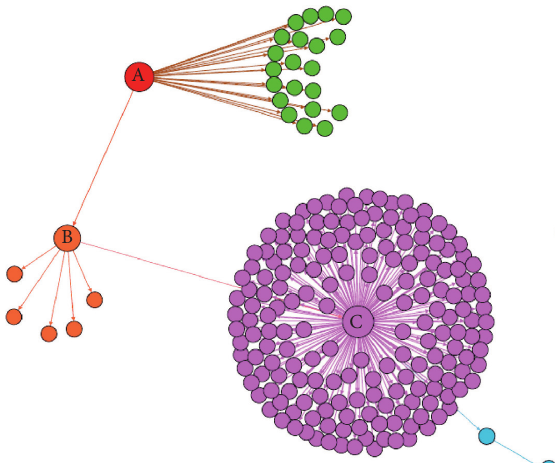
Figure 5: An example community structure of Sina Weibo information propagation tree. Each set of edges and nodes with same color forms a community. In fact, each community is actually a subgraph of the IPT, and it is also a tree structure. The central node of each community is often the first user to spread information in the community.